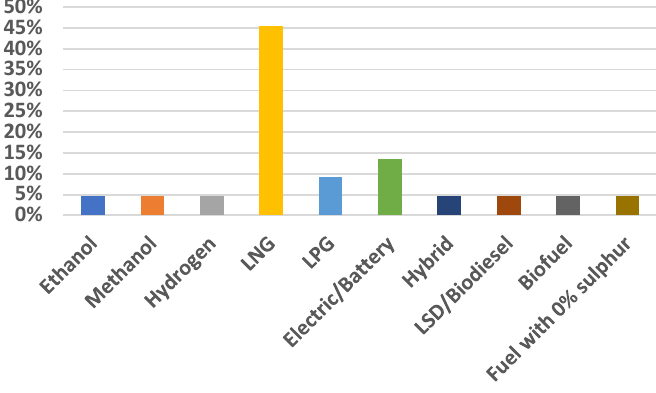
Figure 3. Alternative fuel for Indonesia shipping sector.